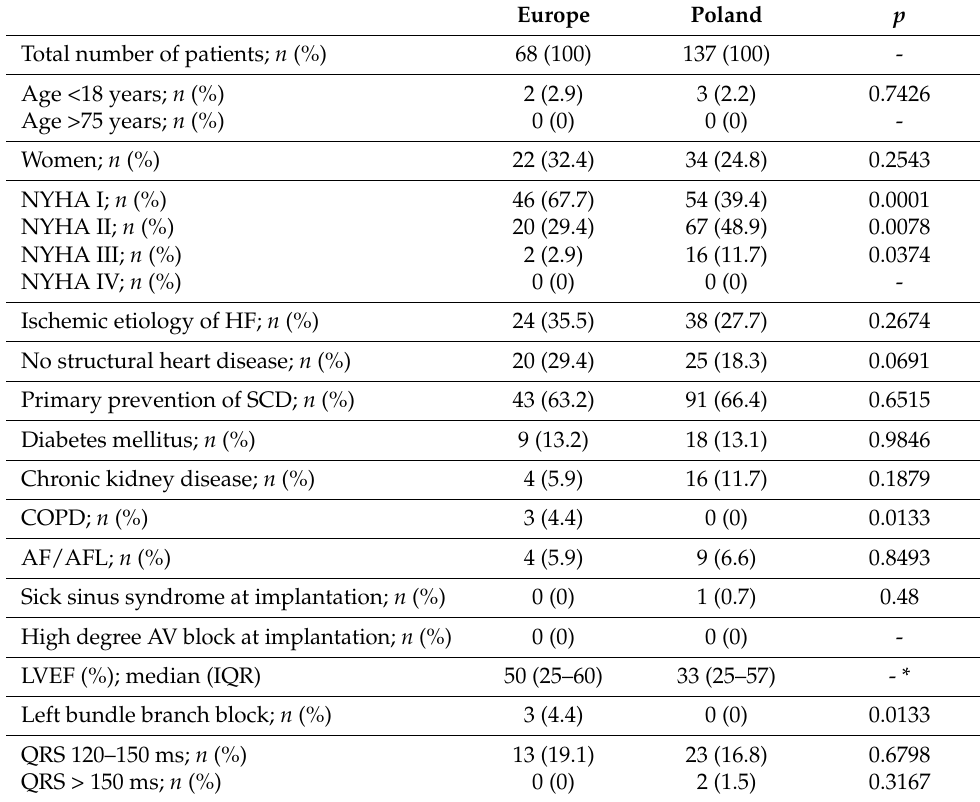
Table 2. Comparison of clinical characteristics between the study group and the ESSS-SICDI group— J˛edrzejczyk–Patej et al. [9].